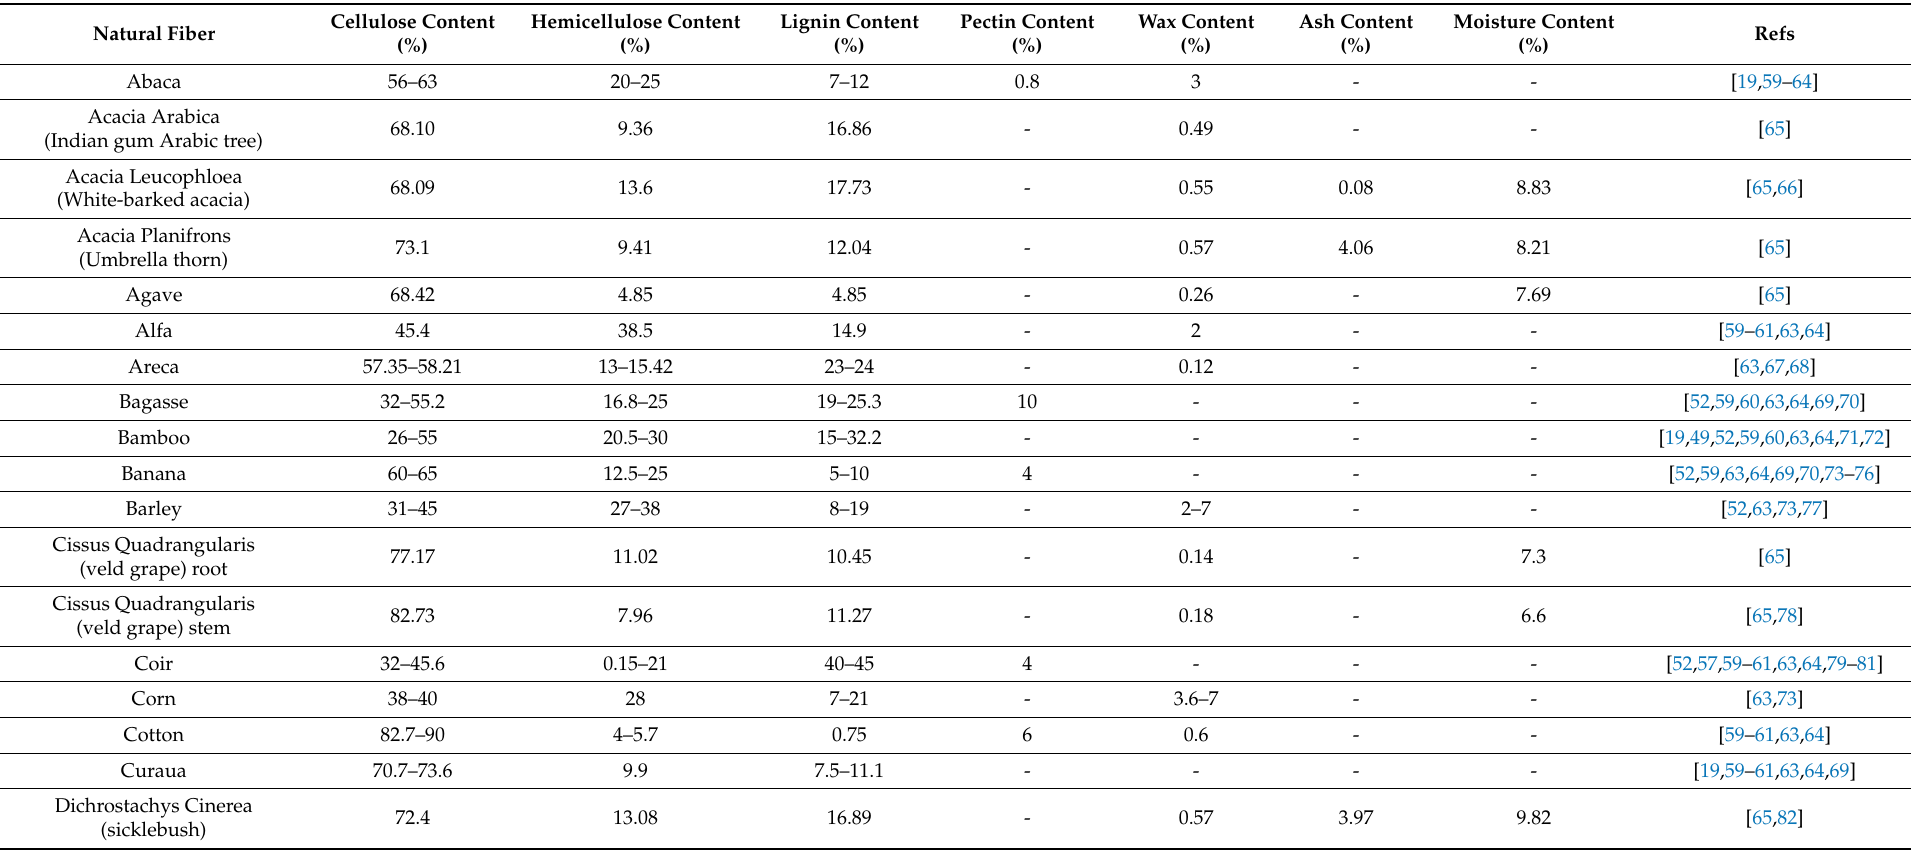
Table 3. Chemical composition of various natural